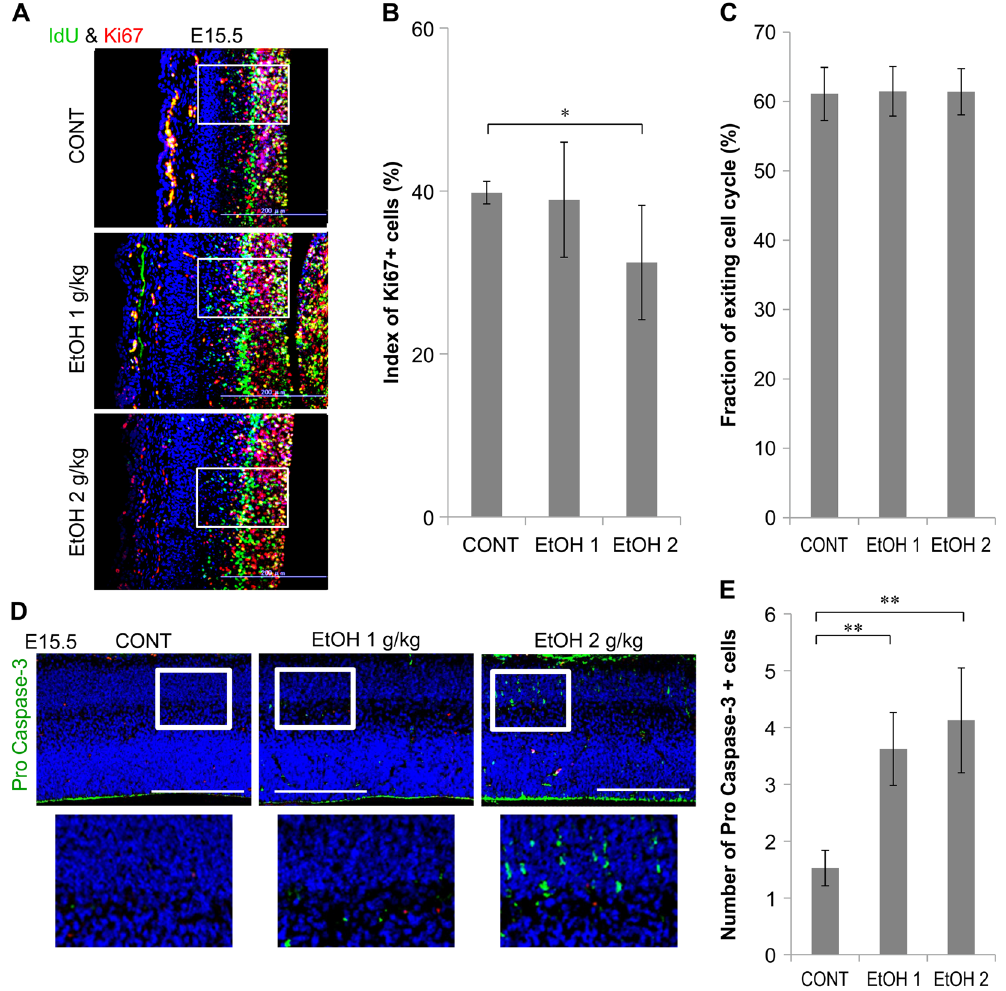
Figure 1. Decreased proliferation of neural stem cells and increased apoptosis in the embryonic dorsal telencephalon due to prenatal EtOH exposure. ( A ) Images showing parasagittal brain sections of E15.5 embryos stained with anti-Ki67 and anti-IdU antibodies 24 h after IdU pulse labeling in control (n = 6) and EtOH-treated embryos (n = 6, respectively). Images were used to estimate proliferation and cell cycle exit (neurogenesis). ( B ) Graph depicting the number of Ki67 + cells (red and yellow in A, white boxes in A) in E15.5 embryos. ( C ) Graph displaying the ratio of IdU + /Ki67 − (green, a measure of the absence of cell division, white boxes in A) to all cells labeled with IdU (green and yellow) 24 h after labeling. This ratio was used as a measure of cell cycle exit. ( D ) Images of parasagittal sections from E15.5 (n = 6) and EtOH-treated embryos (n = 6, respectively) stained with anti-active & pro-caspase-3 antibody. White boxes indicate the regions from which high magnification images in the bottom row were taken. ( E ) Graph depicting the quantification of cells in the whole image. Scale bar, 200 µ m. * P < 0.05, ** P < 0.01, compared to 0 mg∙kg − 1 controls using Dunnett’s test or Steel’s